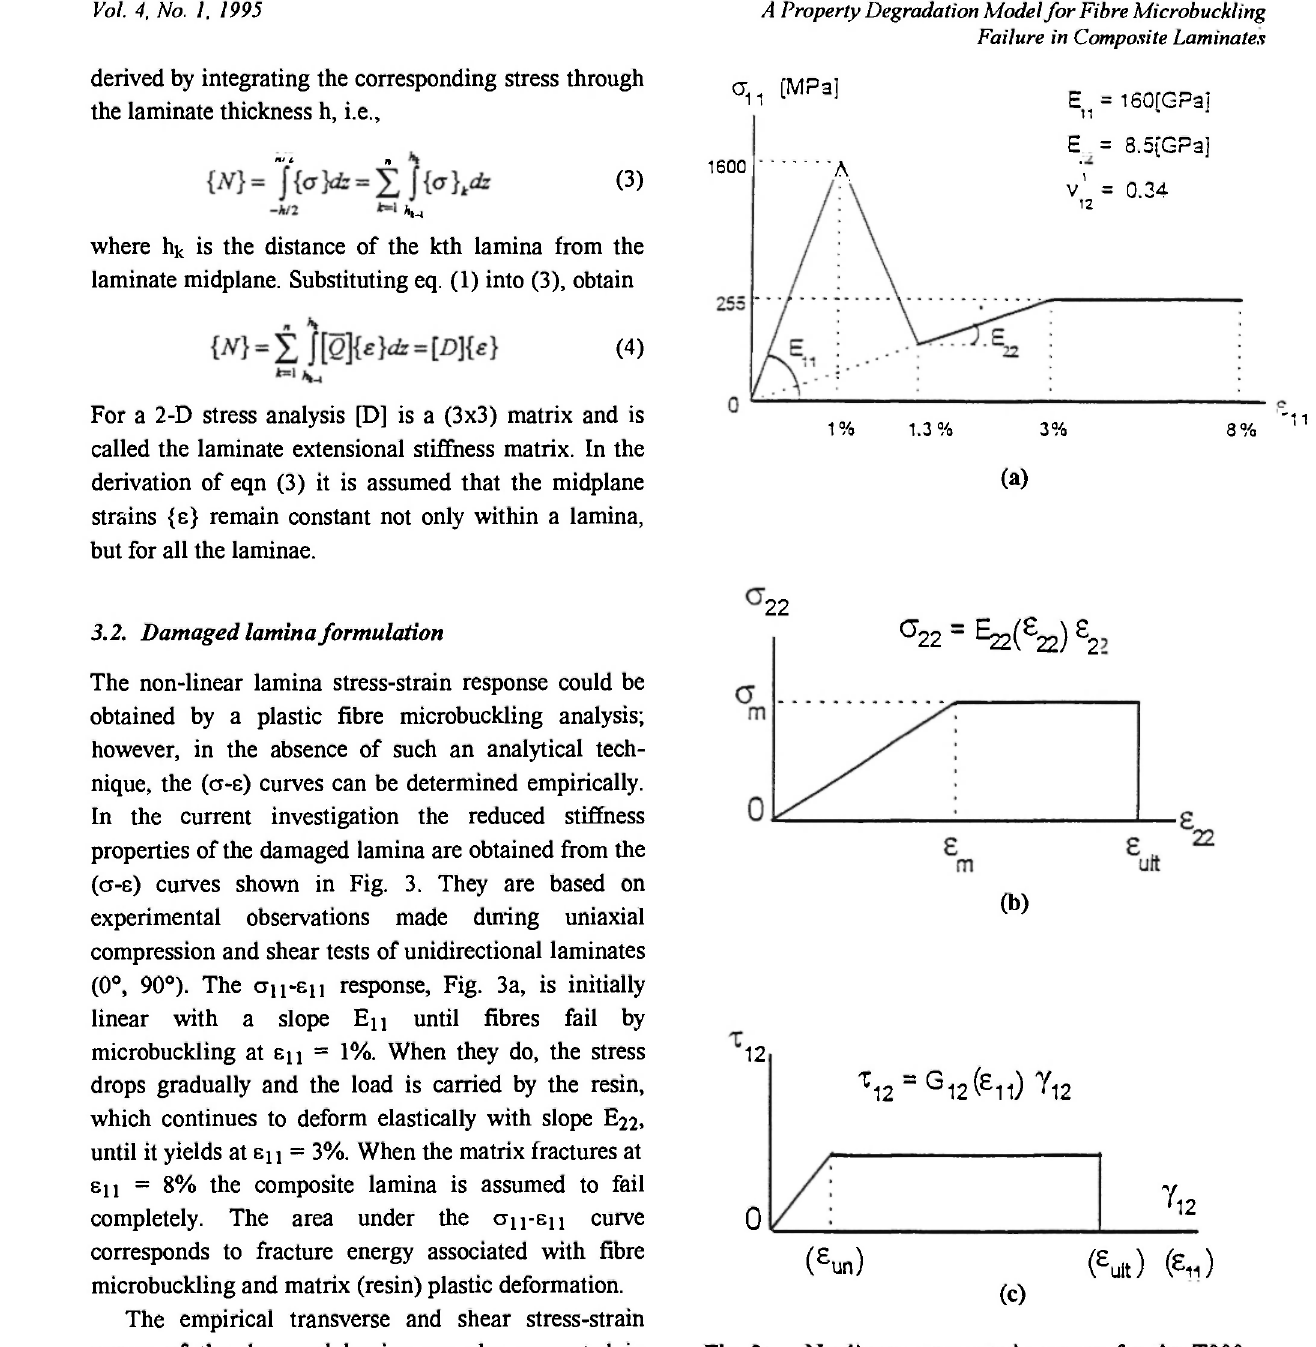
Fig. 3: Nonlinear stress-strain curves for the T800- 924C microbuckled